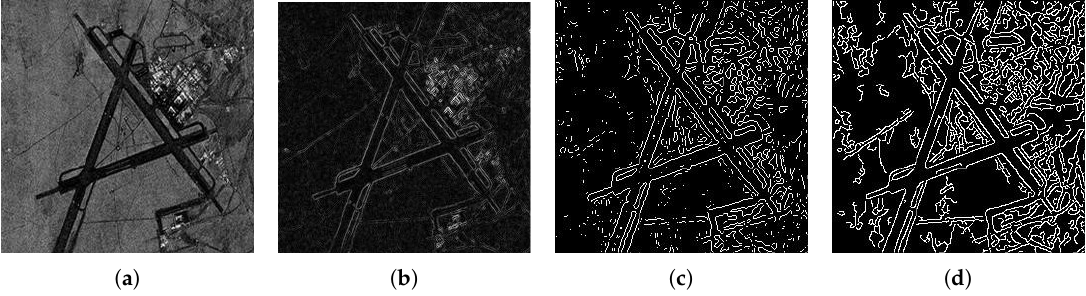
Figure 2. The edge detection results of SAR image2. ( a ) Original image; ( b ) first-order result; ( c ) Gaussian–Laplacian operator result; ( d ) Canny operator